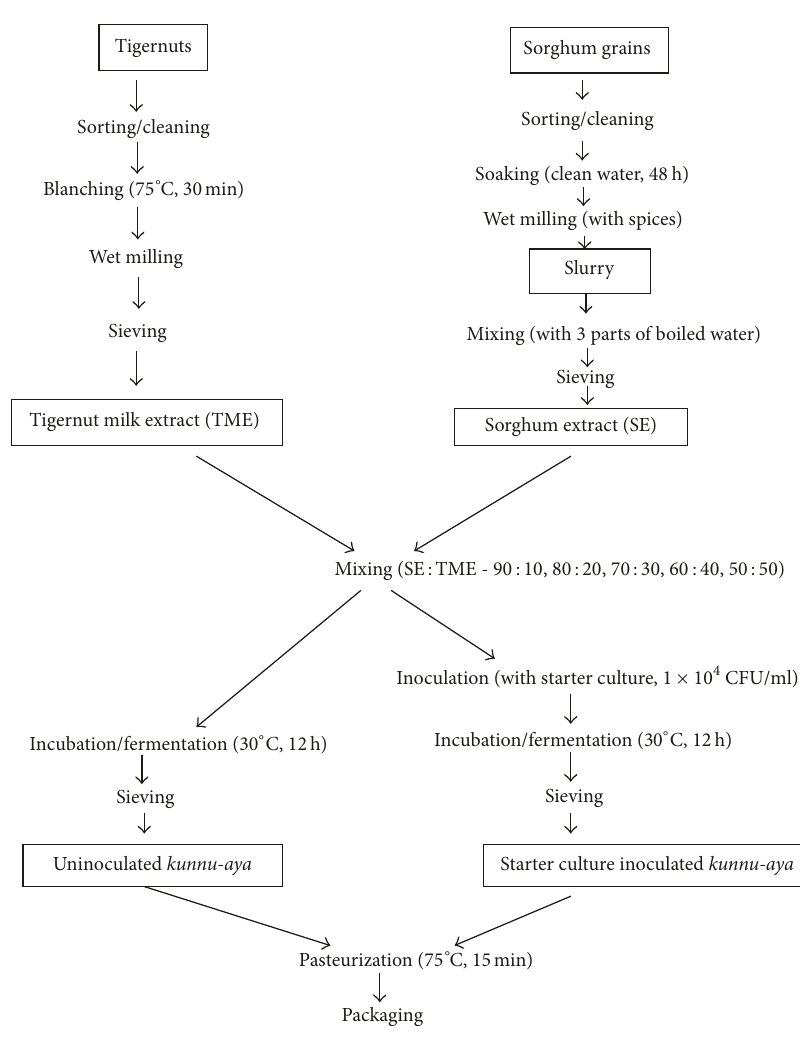
Figure 1: Flow chart for production of starter culture inoculated and uninoculated kunun-aya .